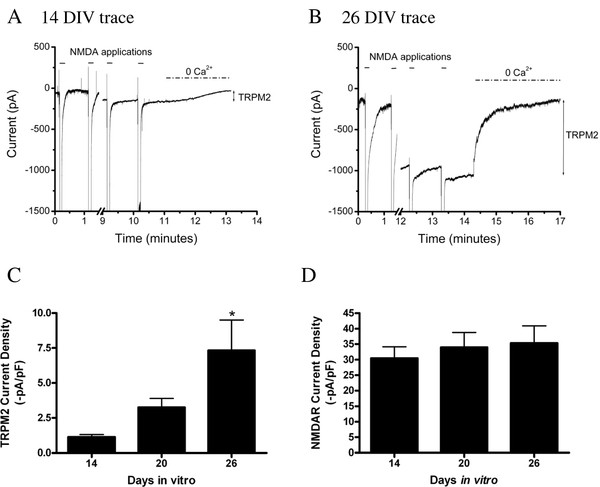
TRPM2 currents are enhanced in hippocampal pyramidal neurons with time in vitro. With 1 mM ADPR included in the patch pipette, TRPM2 currents developed slowly following repeated (1/60 sec) applications NMDA (100 μM, for 5 sec). TRPM2 currents were quantified by removing extracellular calcium and amplitude was normalized to cell capacitance. NMDA applications are indicated with solid lines. Calcium-free application is depicted as a dashed line (A) Representative trace of TRPM2 currents recorded at 14 DIV (B) Representative trace of TRPM2 currents recorded at 25 DIV. (C) Current density at 14, 20, and 26 DIV (n = 5 per group) were compared by one-way ANOVA followed by post-hoc Tukey's test. A significant increase in TRPM2 current density between 14 and 26 DIV was observed (p < 0.05). (D) NMDAR current density is not significantly increased over time in vitro (p = 0.76).